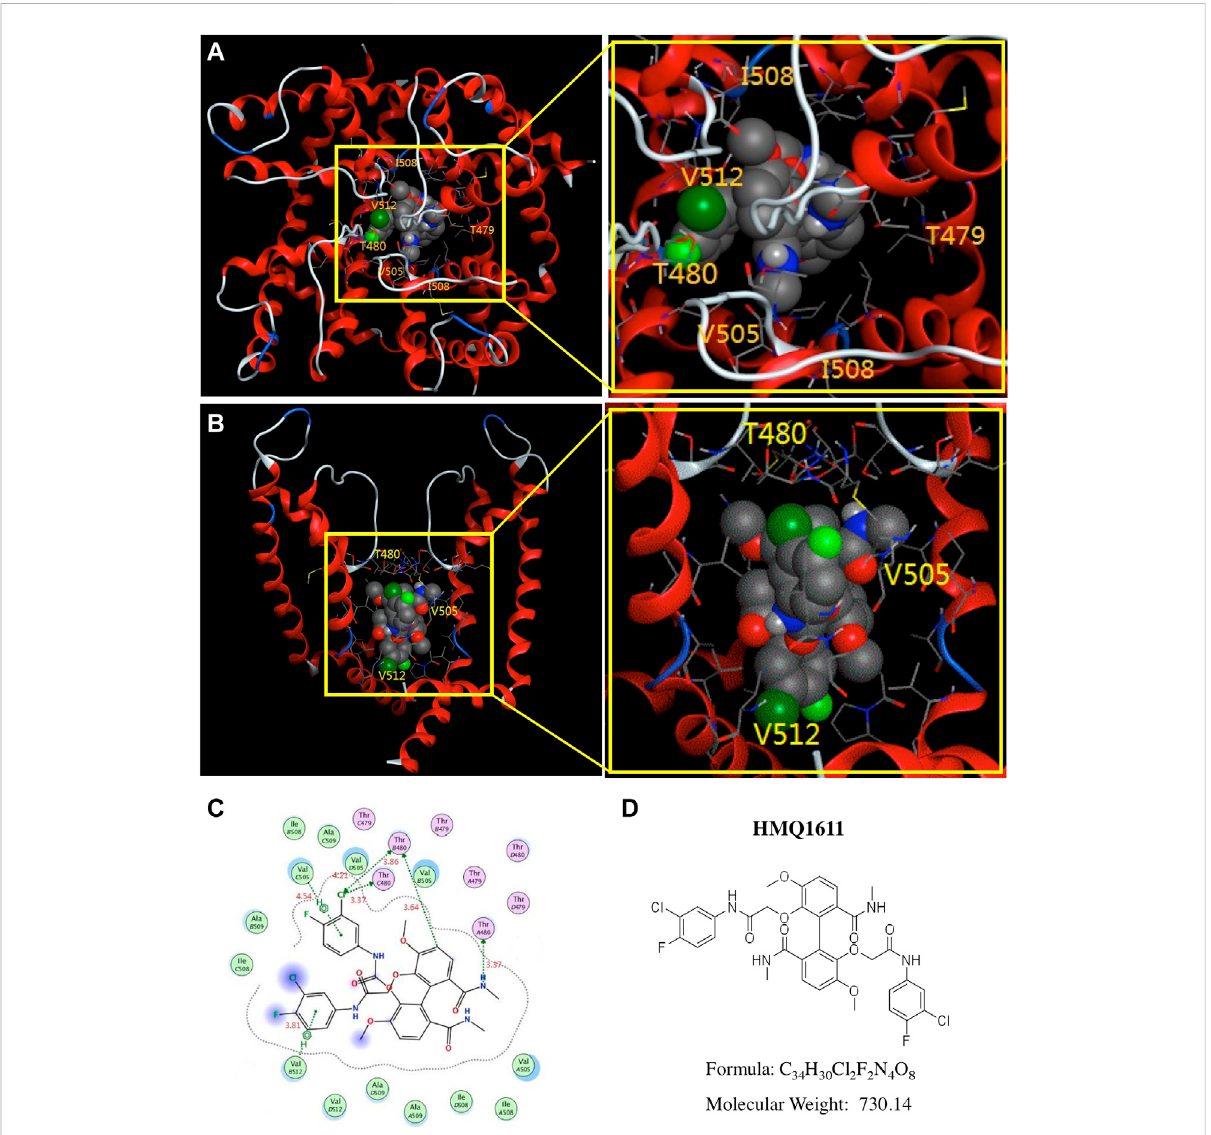
FIGURE 5 Molecular docking of HMQ1611 with Kv1.5 channel. (A) Top view of HMQ1611 docking to hKv1.5 channel pore, indicating the binding of HMQ1611 in central cavity of the channel. (B) A side view of HMQ1611 binding sites (T480, V505 and V512) in the S6 domain and selectivity fi lter of hKv1.5 channel pore. (C) Two-dimensional interaction map of HMQ1611 and hKv1.5 channel. The arrows indicate potential interactions between amino acid residues and HMQ1611. (D) The chemical structure of